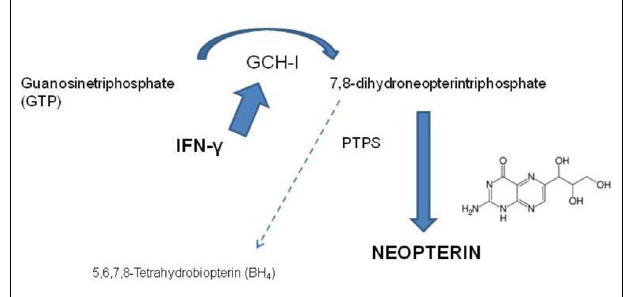
FIGURE 2 | In various cells theTh1-type cytokine interferon- γ (IFN- γ ) induces the GTP-cyclohydrolase I (GCH I) to produce 7,8- dihydroneopterintriphosphate. Due to a deficiency in pyruvoyltetrahydropterin synthase (PTPS) in human monocyte-derived macrophages and dendritic cells, the production of 5,6,7,8- tetrahydrobiopterin is almost zero and neopterin is produced in high